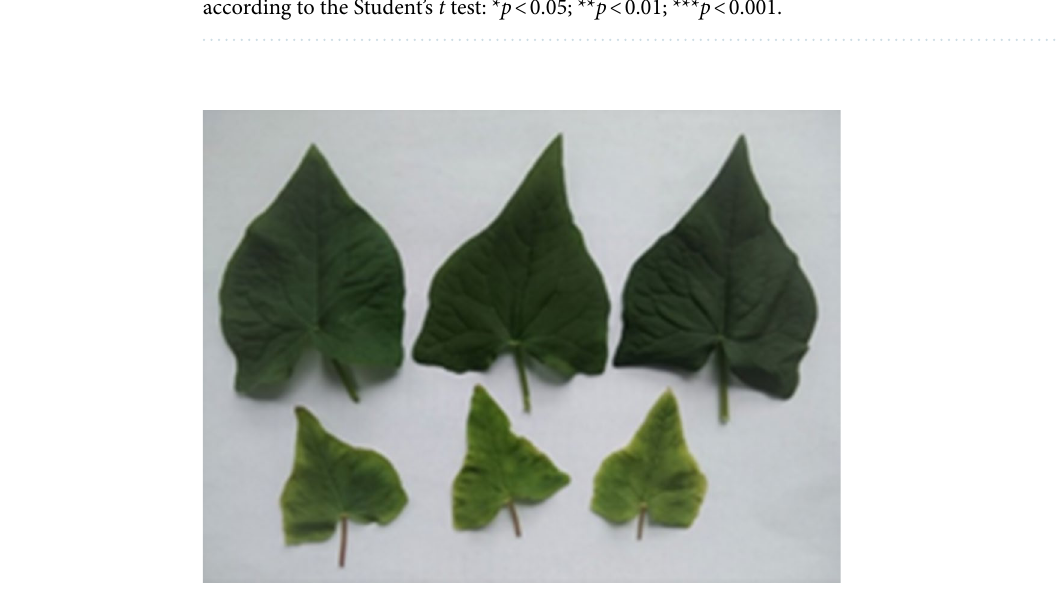
Figure 1. Differences in the leaf area in the plants grown in greenhouse conditions under solar light supplemented with HPS Agro Philips lamps (upper row) and the plants grown in phytotron chambers under LED light (bottom row). All presented leaves were collected at the same time from 8-week-old plants. The sample was the third, fully developed leaf in order from the top